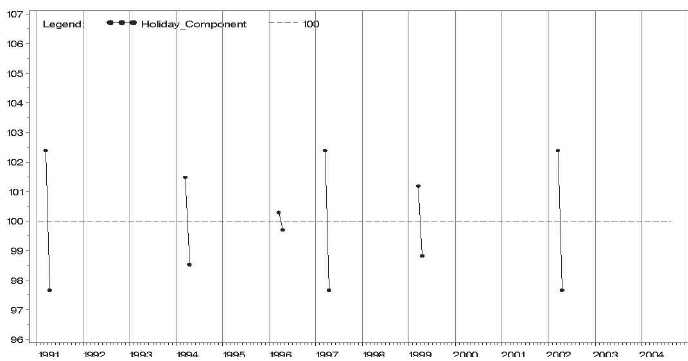
Fig. 2 – Moving Holiday component of the Sales by Canadian Department